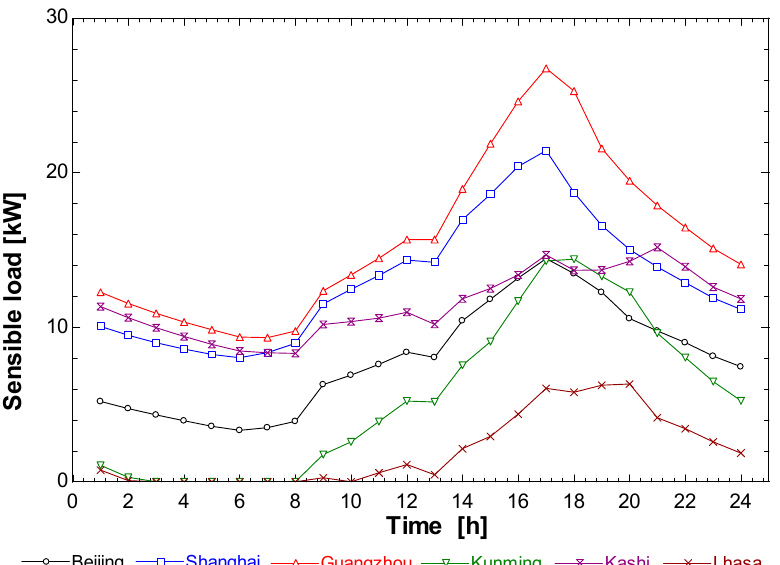
Figure 11. Comparison of total energy consumption for peak day in each selected city.